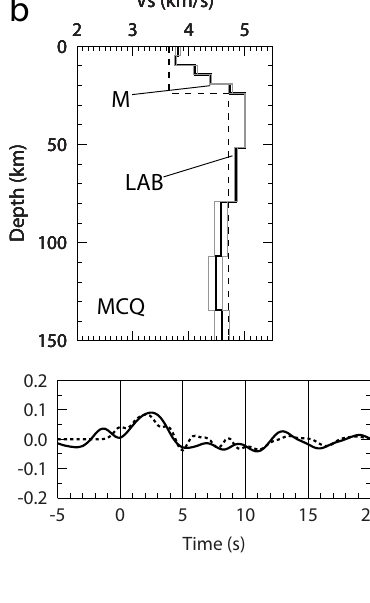
Figure 5. Same as Fig. 4 for the stations RPN and